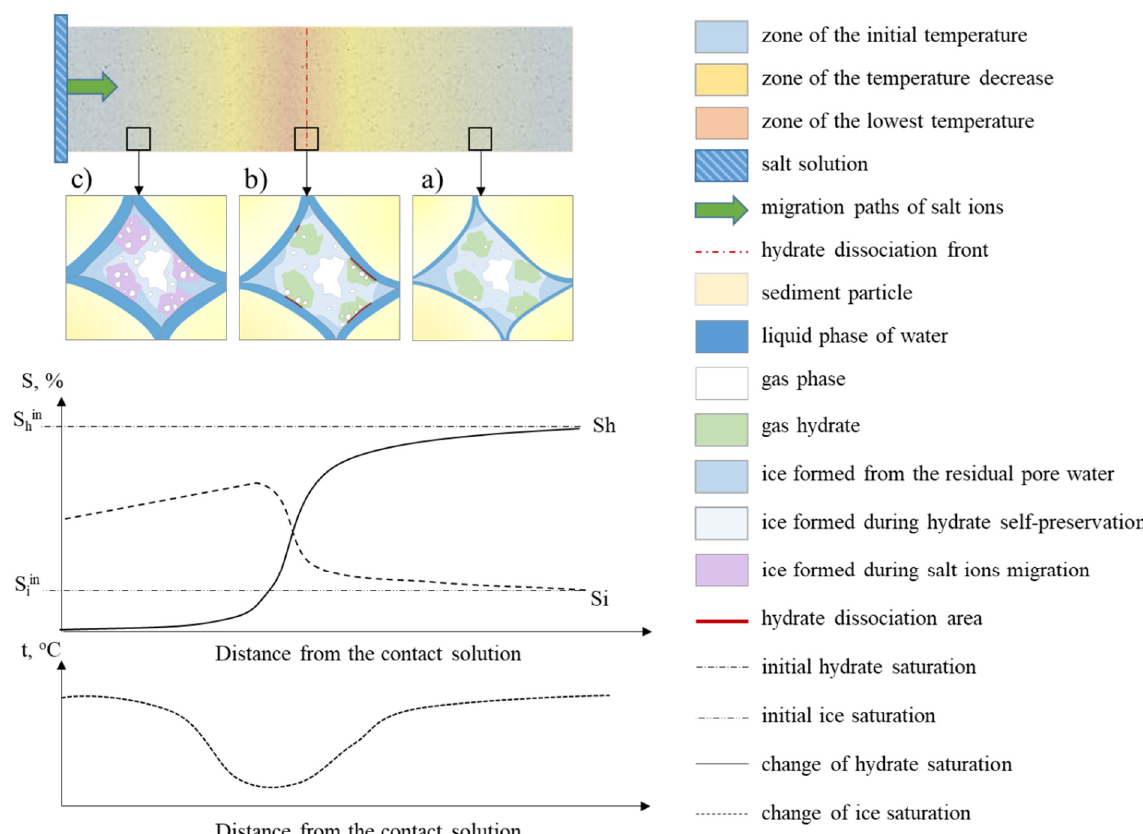
Figure 13. Temperature changes caused by salt migration in frozen sand containing metastable gas hydrates, accompanied by phase transitions of pore moisture and variations of ice and hydrate saturation along the sample. Detailed description in the text.